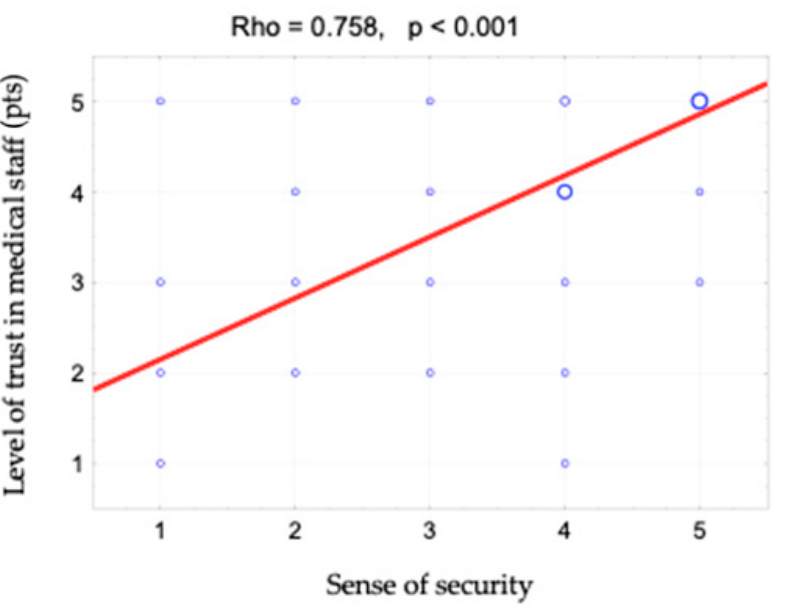
Figure 4. Correlation diagram between the sense of security (1—definitely not, 2—rather not, 3— partially, 4—rather yes, 5—definitely yes) and kindness and the value of Spearman’s rank correla- tion coefficient (rho) .